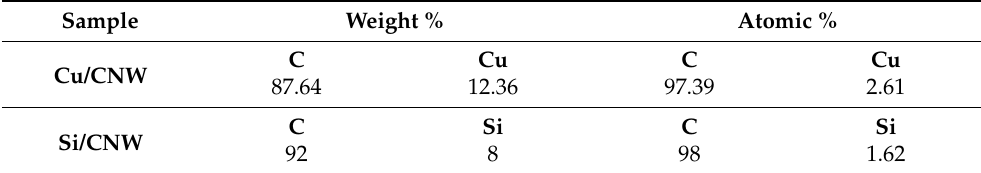
Table 3. The element ratio of Cu and Si-coated CNWs samples.